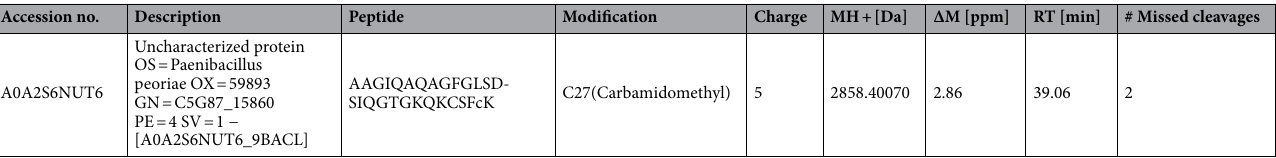
Table 2. Protein group accession list from LC–MS data and the peptide sequence generated from MS-ion search.